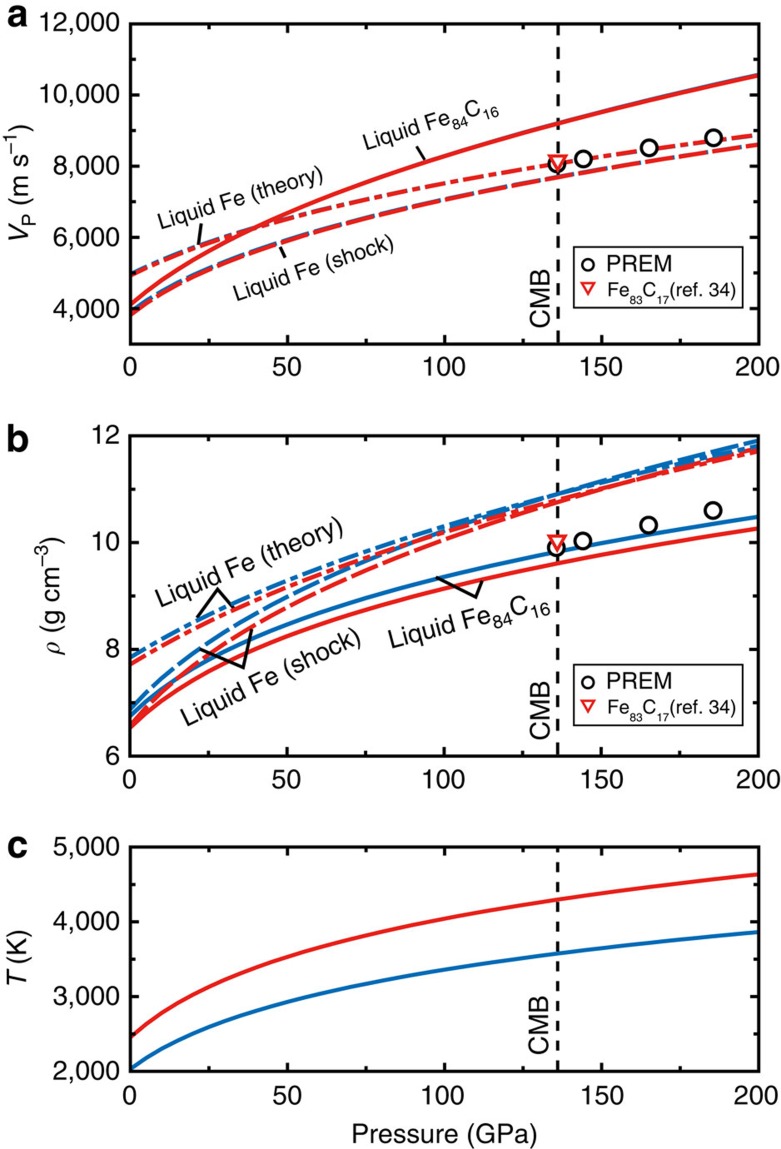
Velocity and density of liquid Fe84C16 extrapolated to core pressures.The P-wave velocity (a) and density (b) profiles of liquid Fe84C16 are calculated along two adiabatic temperature curves (c) of 3,600 K (blue) and 4,300 K (red) at the CMB. Those for liquid Fe are from shock-compression experiments8 and theoretical calculations26. The velocity and density for liquid Fe83C17 at the CMB (4,300 K) are by theory34. PREM denotes seismologically deduced Preliminary Reference Earth model35.